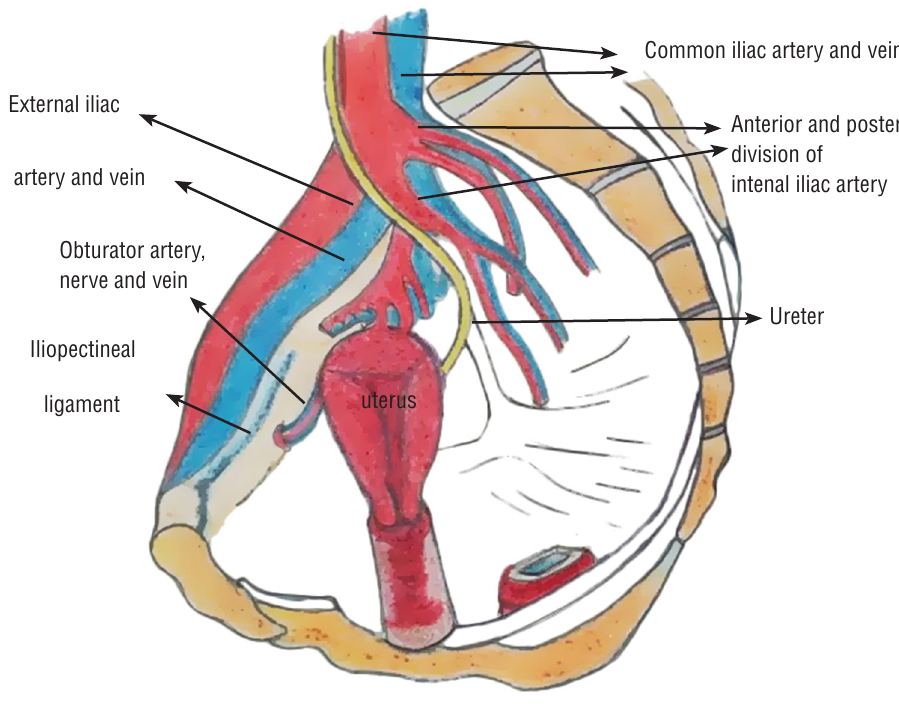
Figure 1 - Anatomic details of the iliopectineal